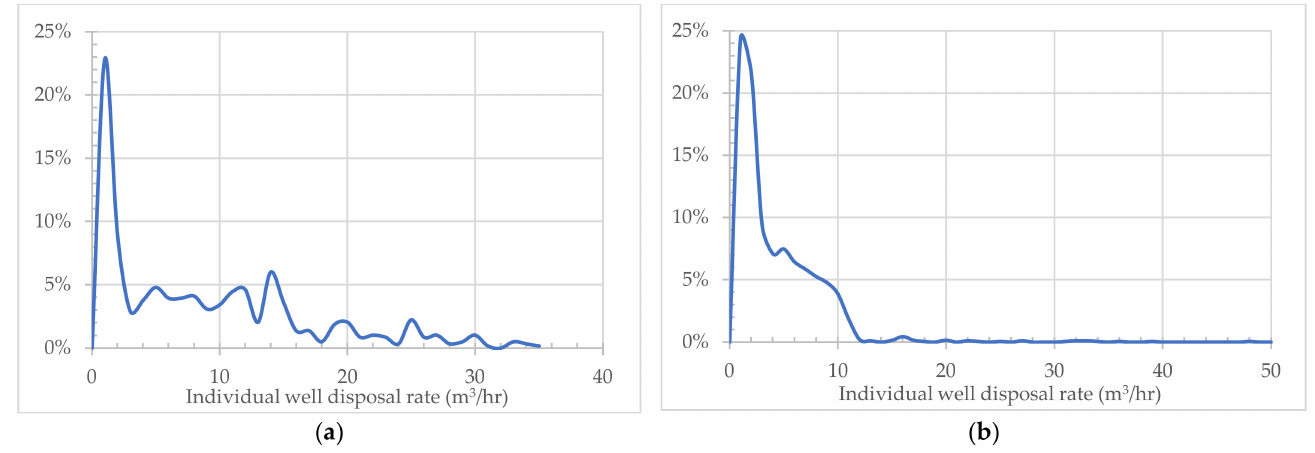
Figure A4. Historical per-well water injection rate ( X -axis) frequency ( Y -axis) distributions (January 1962–December 2022) in ( a ) the Peace River Formation; ( b ) the Colony Formation.